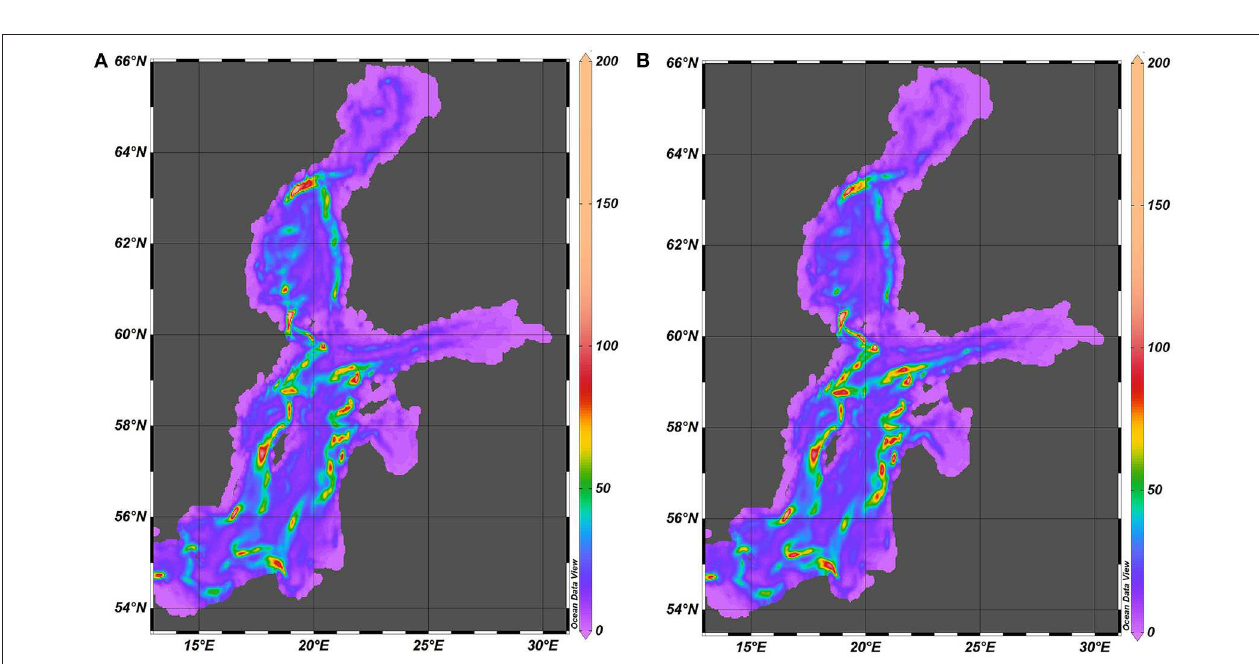
FIGURE 12 | Spatial distribution of kinetic energy (kg · s − 2 ) of internal waves in 1961–1965 (A) and 2000–2005 (B) . The maximum value is 400 kg · s − 2 but for better readability the scale is limited to 200 kg · s − 2 .